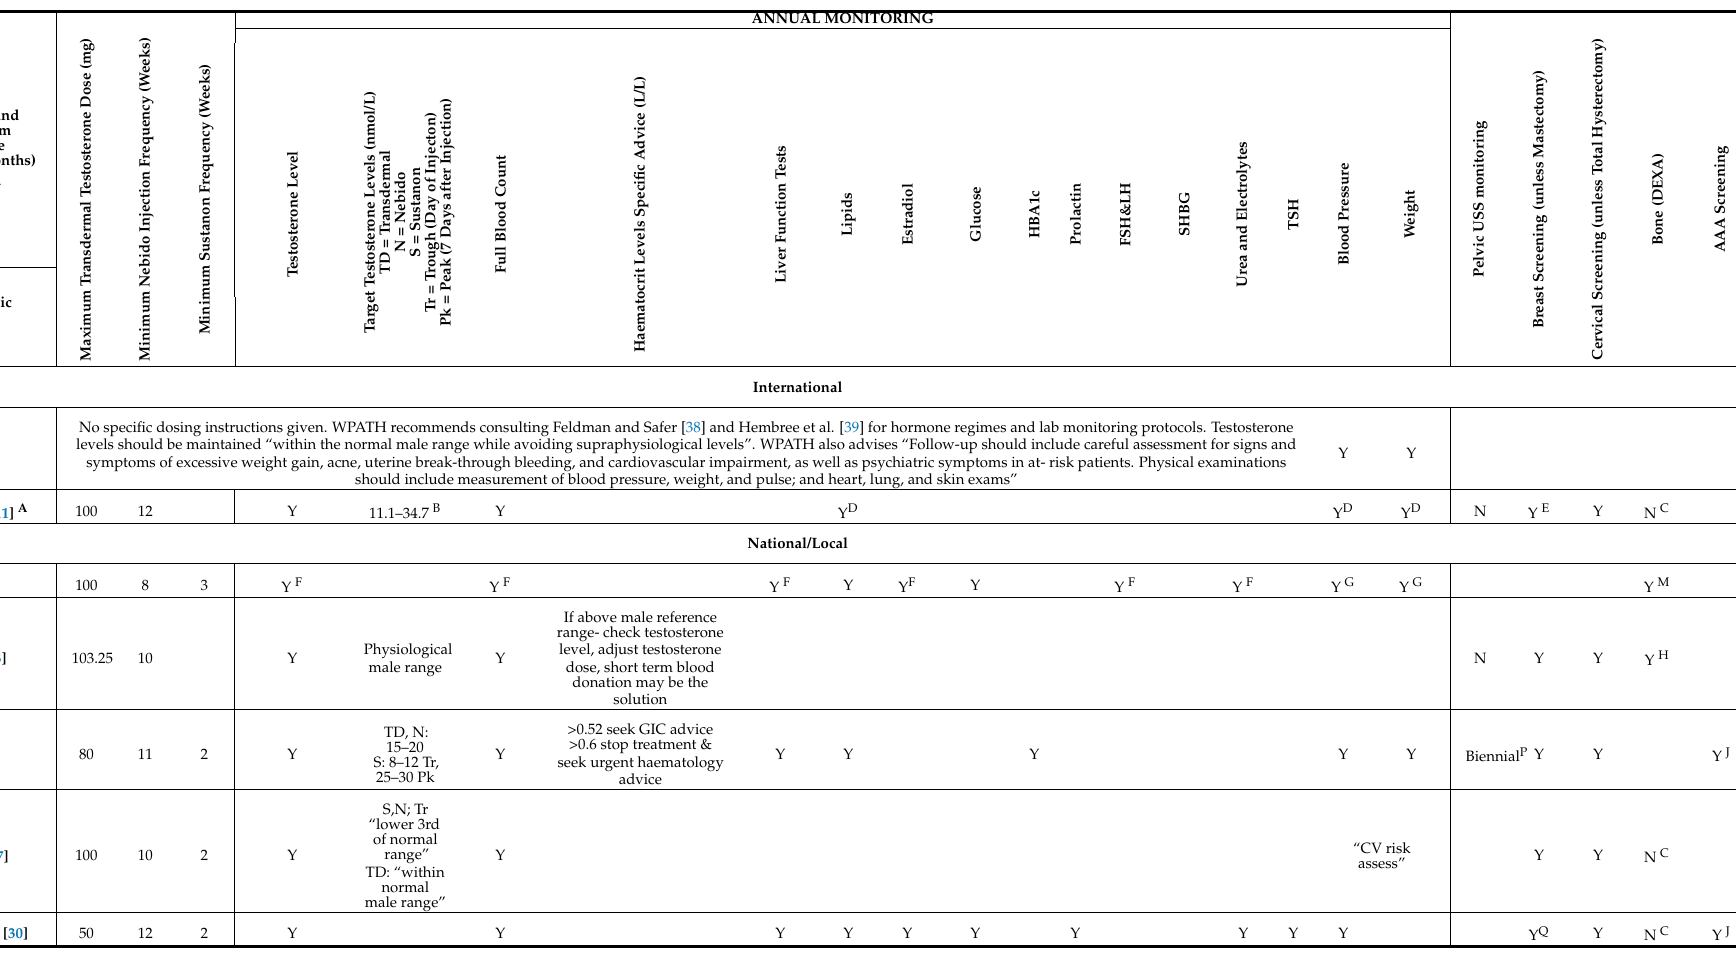
Table 1. Comparison of national, international, and patient specific prescribing and monitoring guidelines for trans men (observed females at birth) with gender dysphoria. Table 2. Comparison of national, international, and patient specific prescribing and monitoring guidelines for trans women (observed males at birth) with gender dysphoria.